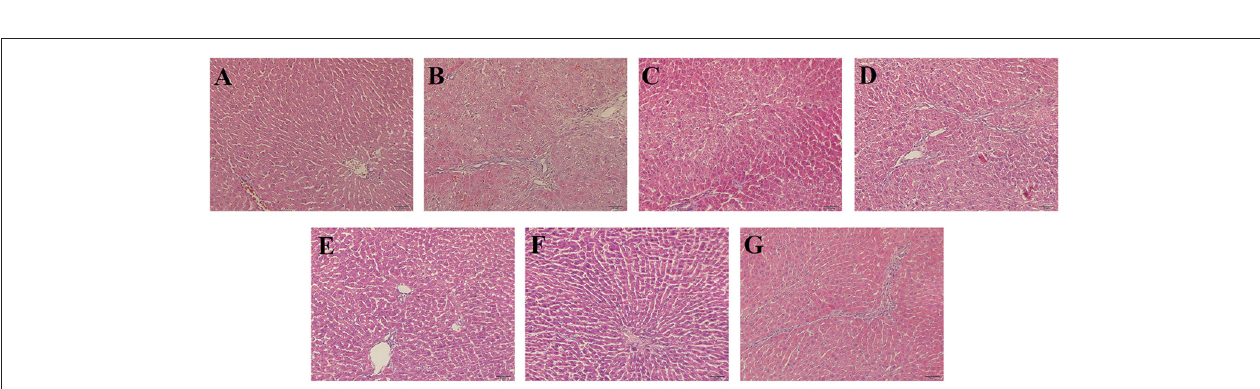
FIGURE 1 | Body weight increase, liver index and biochemical assays results after ZYCH treatment in DMN-induced liver fibrosis. (A,B) body weight increase and liver index; (C-G) serum ALT, AST, AKP, Alb, TBIL level; (H,I) the production of Hyp and TNF- α in liver tissues. # p < 0.05, ## p < 0.01 vs. control group, * p < 0.05, ** p < 0.01 vs. model group.